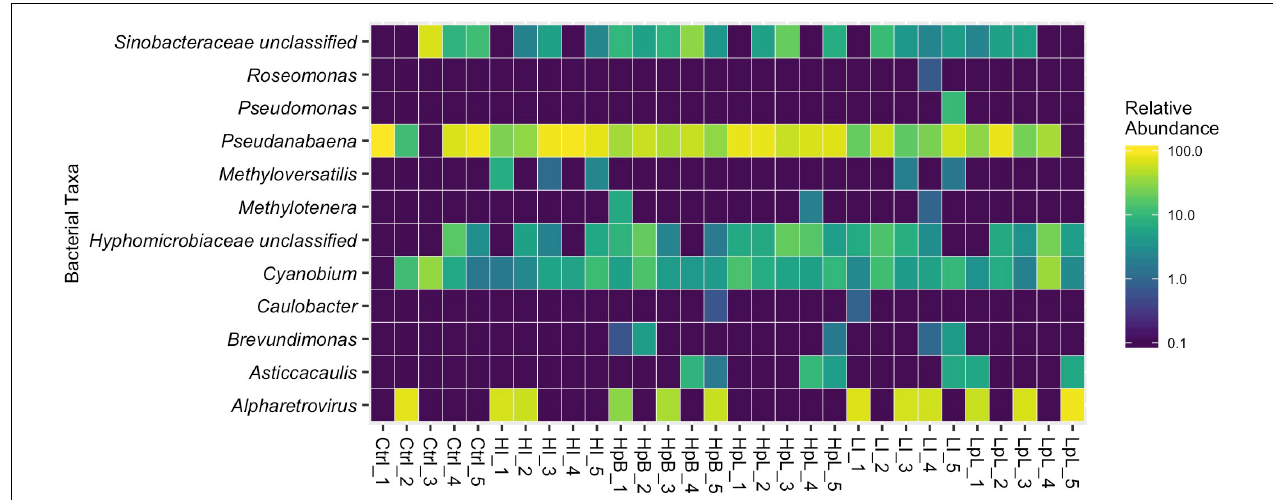
FIGURE 3 | Relative abundance of biofilm microbial community organisms, with no hierarchical clustering applied. Cntrl = control; HI = high ionic Zn; LI = low ionic Zn; HpB = hydrophobic ZnO; HpL = hydrophilic ZnO; LpL = lipophilic ZnO. Numbers indicate